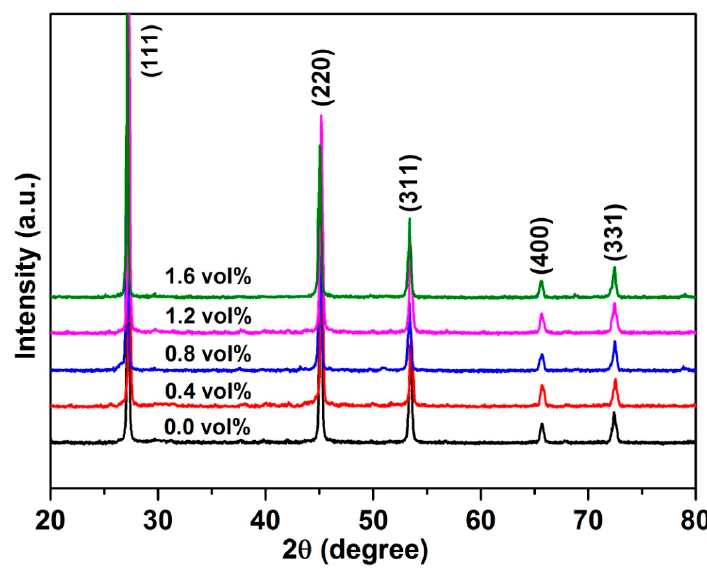
Figure 3. XRD patterns of sintered C 60 /Cu 2 SnSe 3 composites.